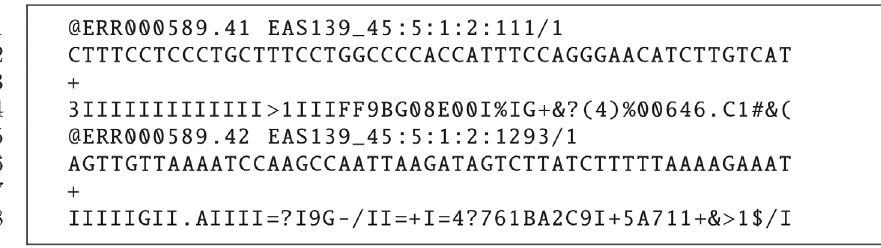
Fig 1. FASTQ file format